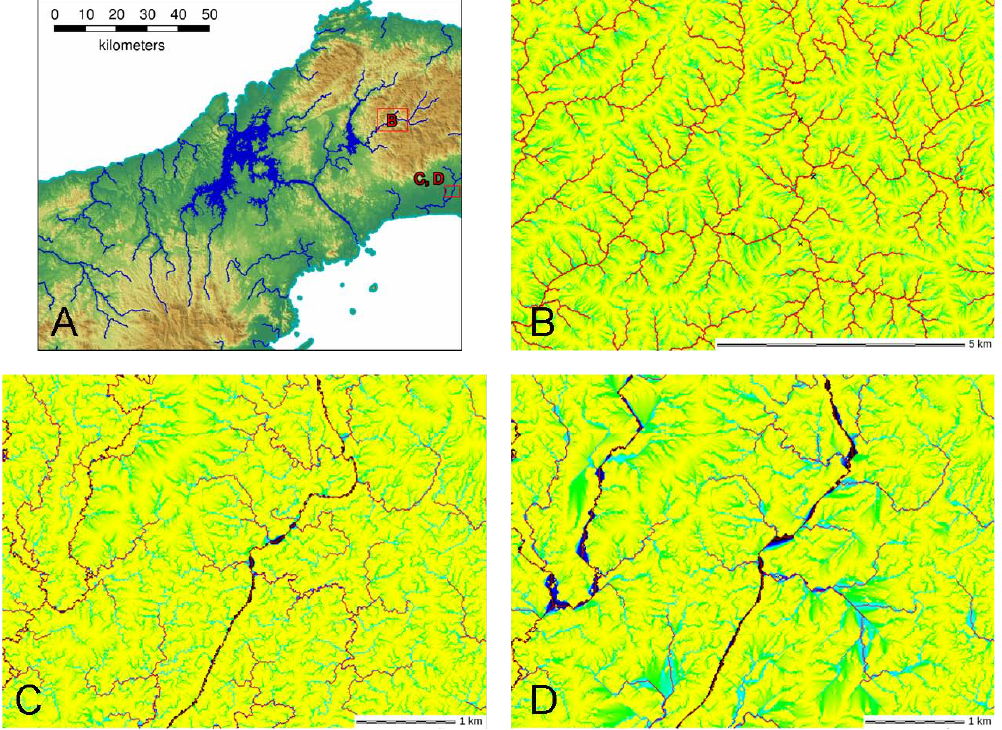
Fig. 4. Extraction of a single main channel: (A) Location of areas shown in images (B) , (C) , and (D) ; (B) The starting points of the extracted streams (red lines) were well upstream of the reference points (black crosses). Flow accumulation derived from IFSARE 10m is used as background. The extracted streams (red lines) are located within broader stream tubes in low-gradient areas close to the coast, for both (C) LCP-derived streams and (D) streams derived with sink filling. IFSARE 10m was used for both (C) and (D) representing the same